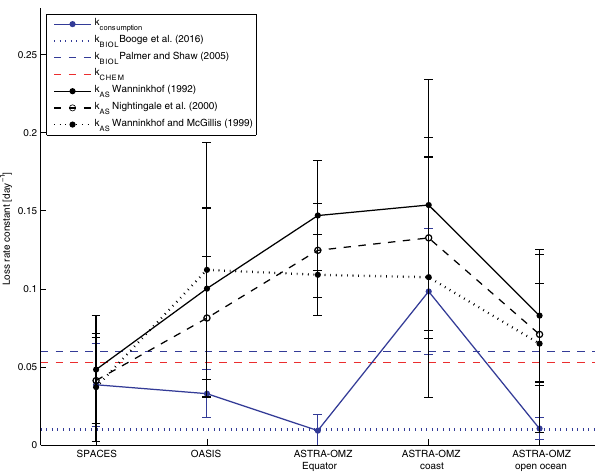
Figure 9. Relationship between isoprene concentration (pmolL − 1 ) and total bacteria counts (mL − 1 ]) during SPACES, OASIS, and ASTRA-OMZ. Black and red points represent samples where the contribution of haptophytes to the total phytoplankton chl a con- centration is higher and lower than 33%, respectively. Linear re- gression ( R 2 = 0 . 80; p = 2 . 34 × 10 − 7 ) for red points only.